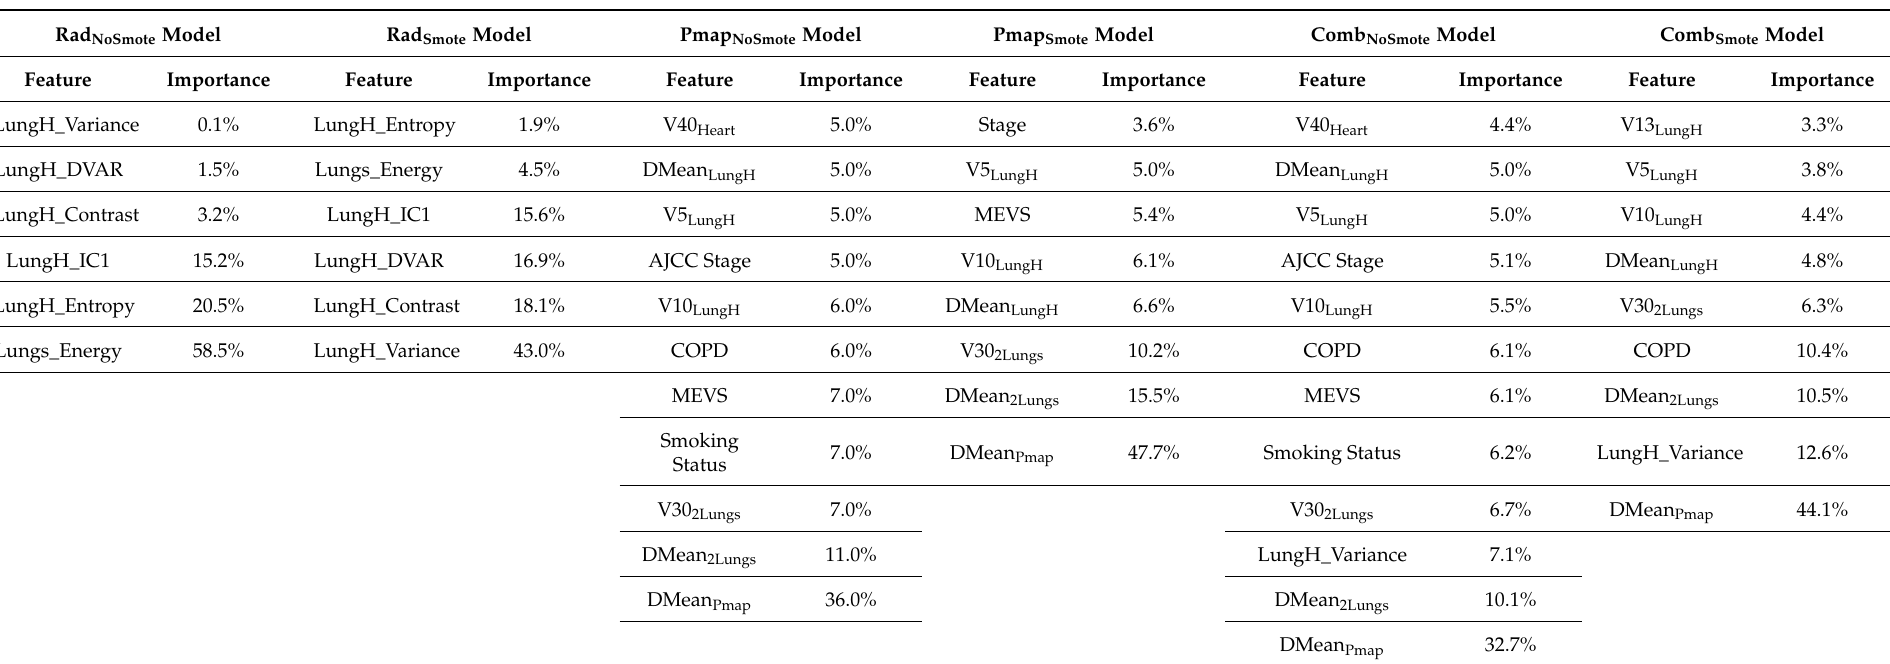
Table 3. Classification of each feature by importance for each